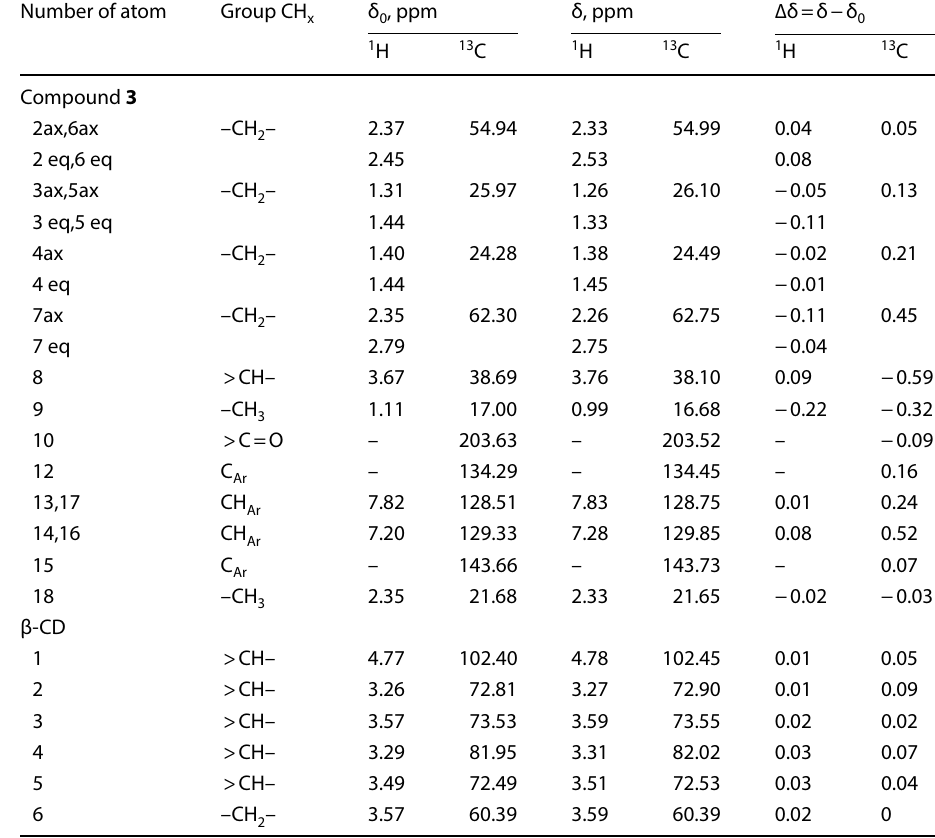
Table 3 1 H и 13 C NMR chemical shift changes (ppm) for 3 and β-CD before (δ ) and after the 0 formation of complex 6 (δ)